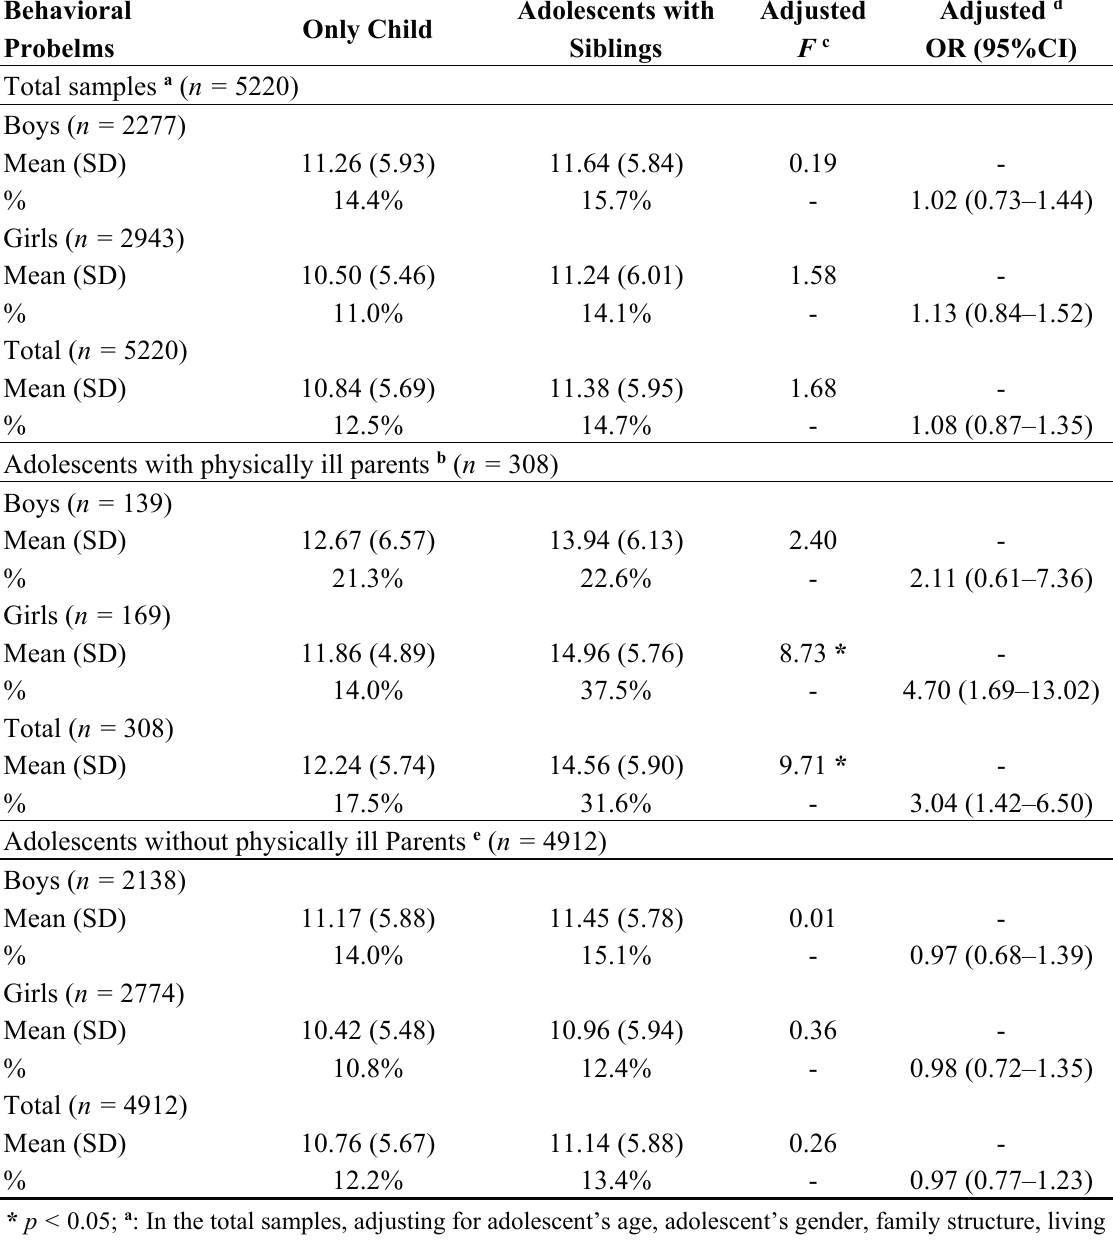
Table 3. The effect of being an only child on behavioral problems in the total sample and adolescents with and without physically ill